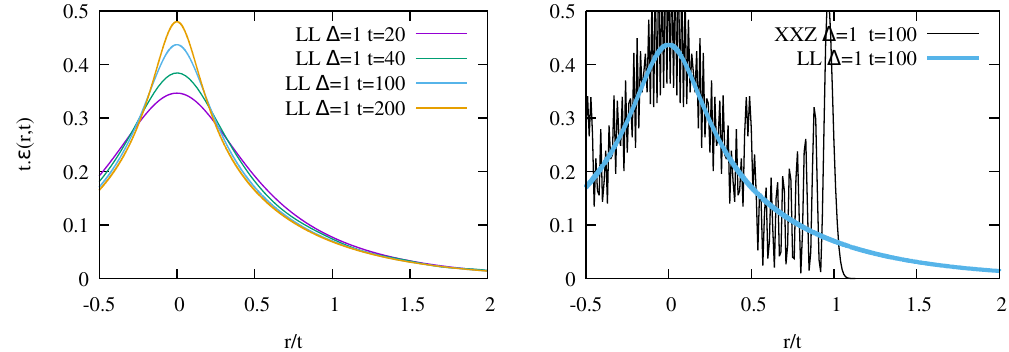
(cid:0) (cid:126) Ω (cid:1) 2 multiplied by t , as a func- r 2